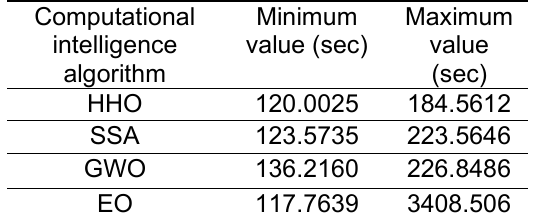
Table 3. Minimum and maximum computational cost of computational intelligence algorithms